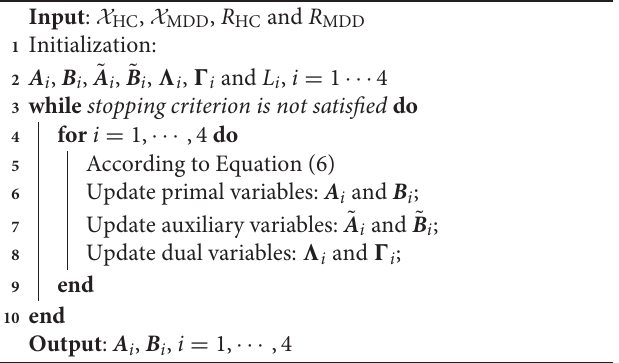
Algorithm 1: NCTF-ADMM